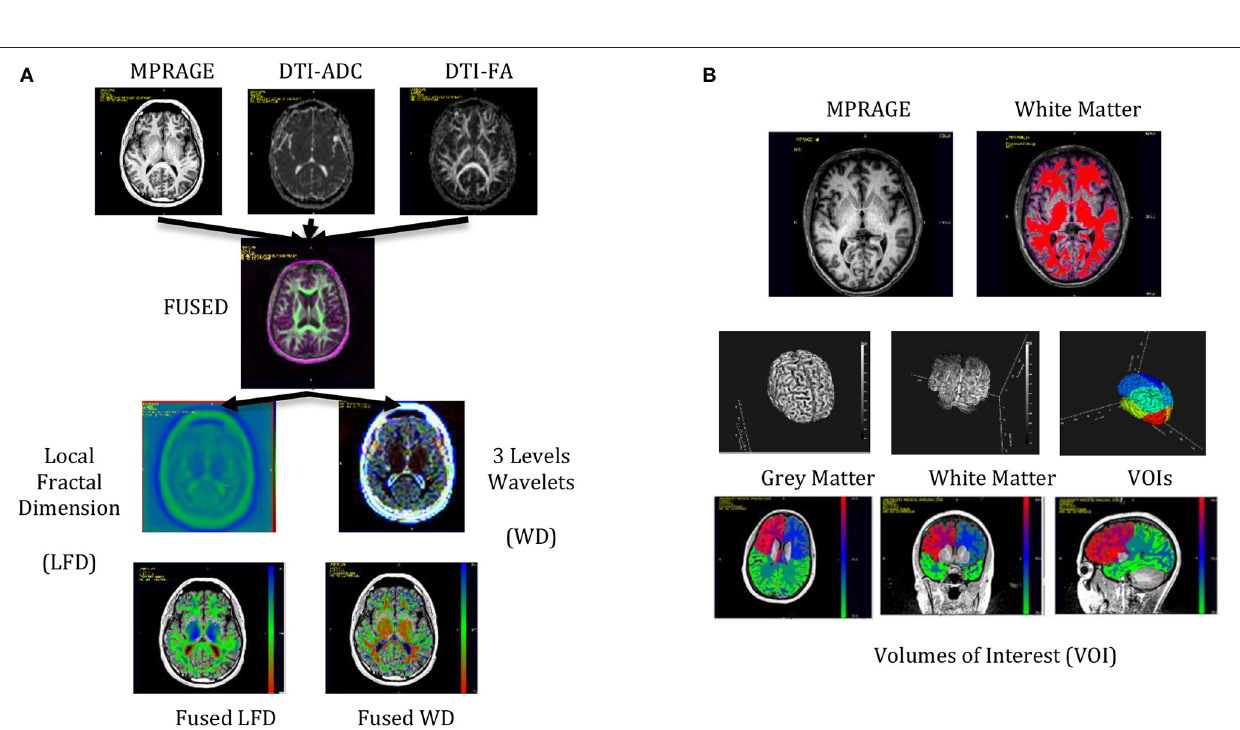
FIGURE 3 | MRI data and Image processing steps carried out for the qMRI to PCS association. (A) Three MRI pulse sequences were fused and processed for the extraction of the local fractal dimension and the wavelets transforms. (B) The fused data sets were segmented into gray and white matter and subdivided in 8 volumes of interest. The two tissue types in each VOI plus the entire white and white matter created 18 regions of interest (ROI).